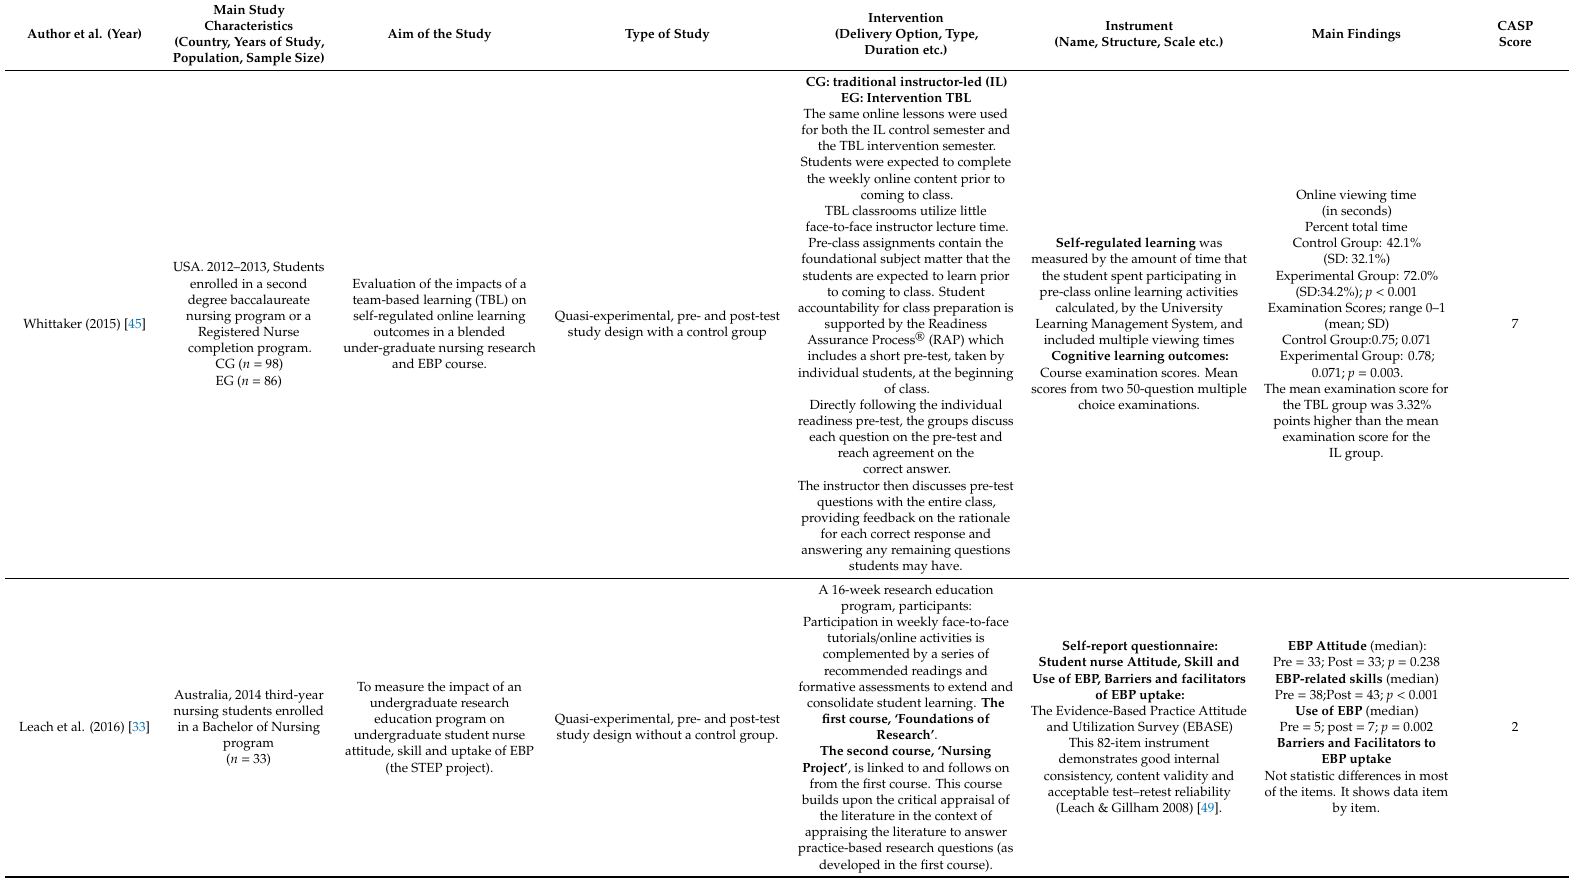
Table 4. Data extraction for both face to face and on-line / by distance used method to teach